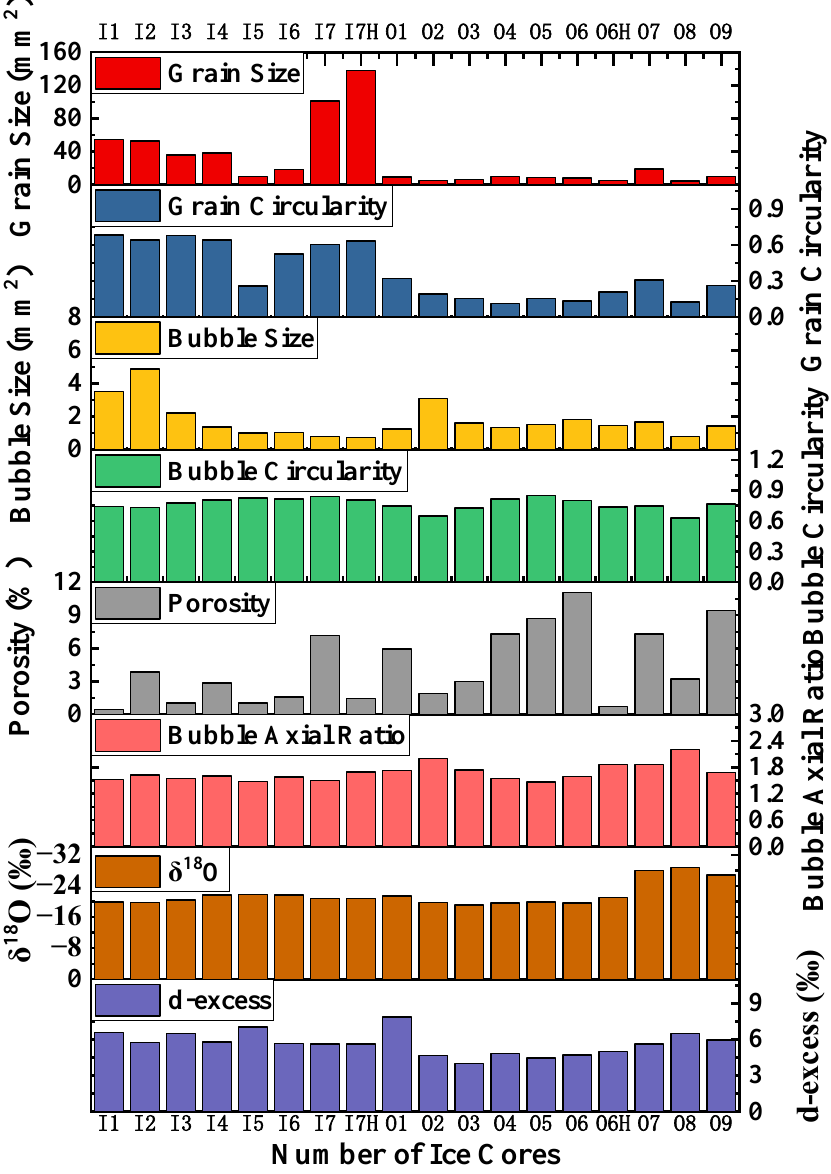
Figure 10. Grain and bubble characteristics of IW (I1-I7H) and OIW (O1–O9) ice cores. ‘H’ means horizontal thin sections, which cut perpendicularly to the drilling direction.